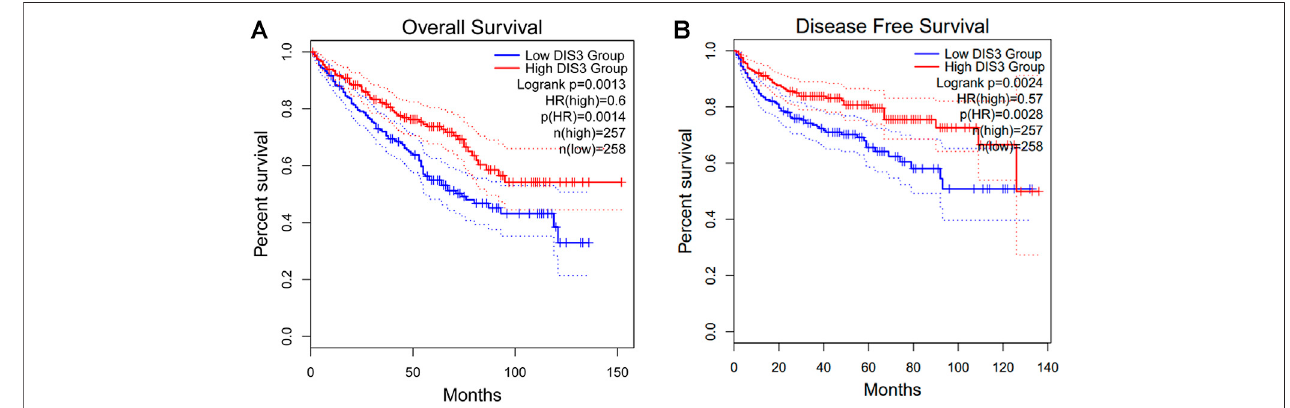
FIGURE 8 | The survival analysis of DIS3 in KIRC. KIRC, Kidney renal clear cell carcinoma.